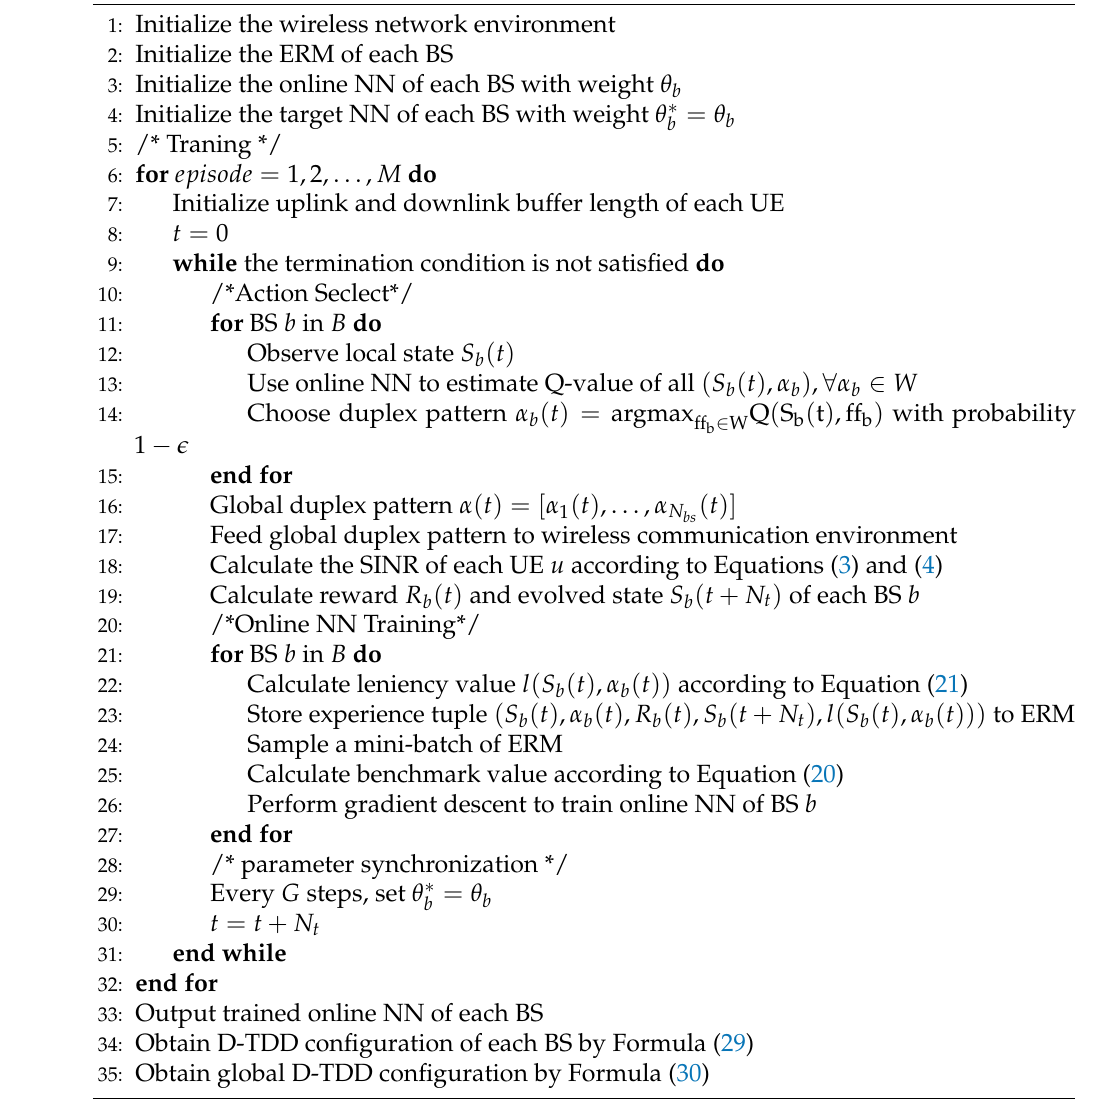
Algorithm 1 LC-MARL based decentralized D-TDD